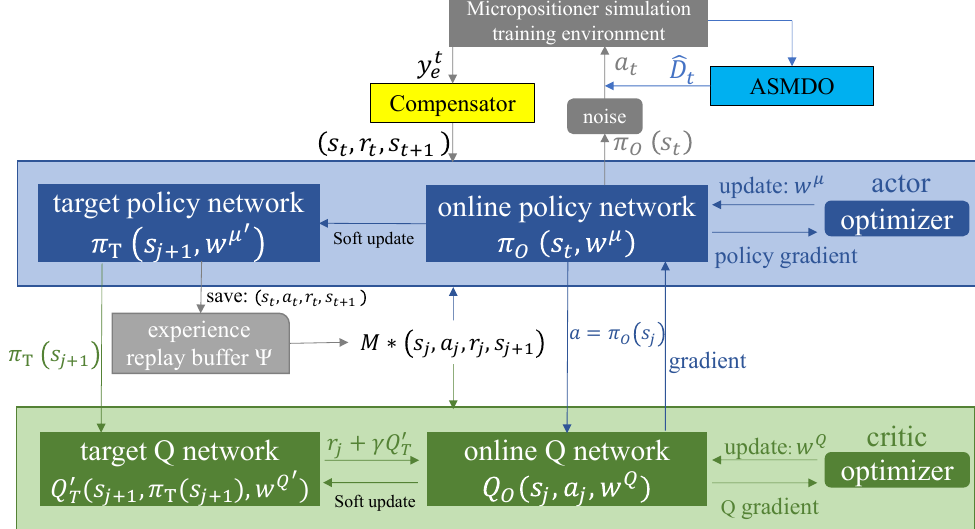
Figure 2. The structure diagram of DDPG-ID